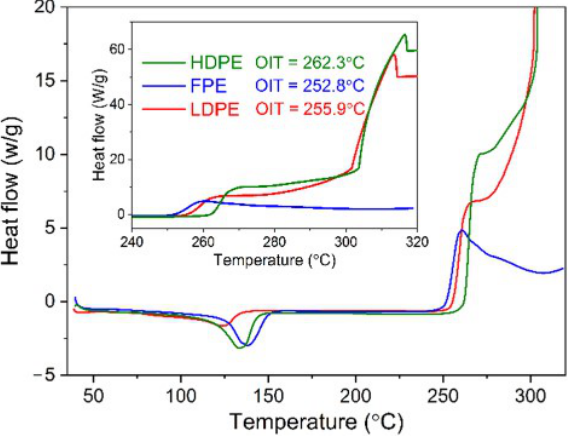
Figure 6. DSC OIT curves of LDPE, FPE, and HDPE materials.